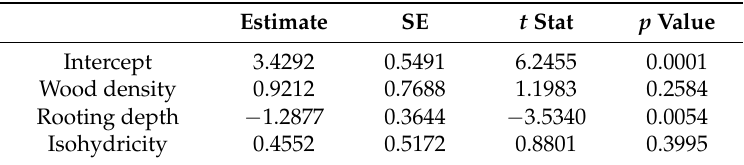
Table 2. Stepwise multiple regression model for drought tolerance explained along the basis of wood density, rooting depth, and isohydricity (Overall model statistics: RMSE: 0.34, R 2 = 0.63, Adjusted R 2 = 0.52, Prob < F =